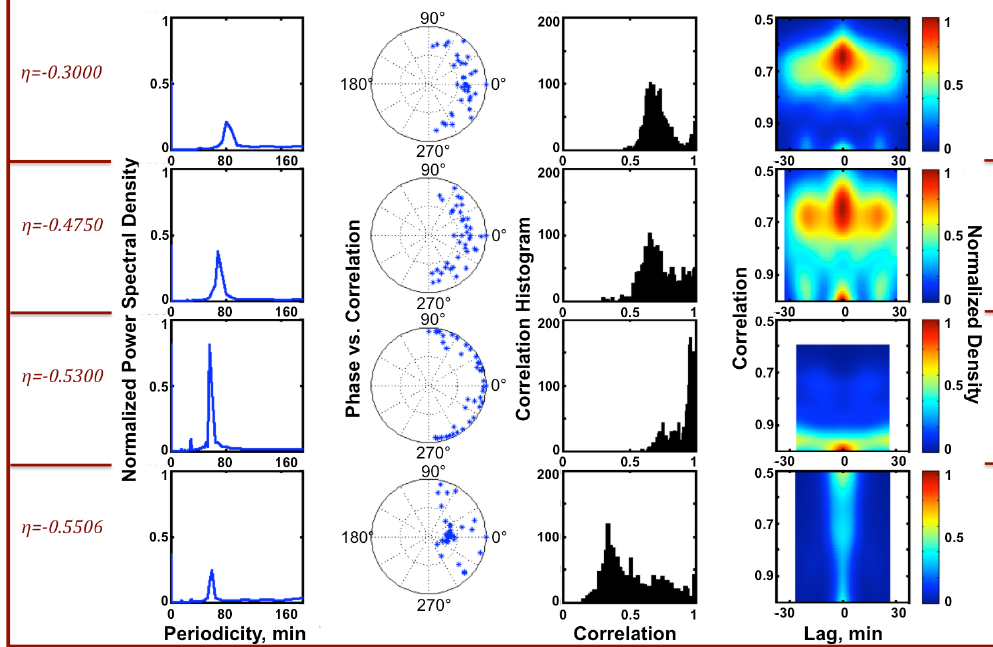
Fig. 9. Summary of the influence of η on an array of 41 clouds for η = − 0 . 3000, − 0.4750, − 0.5300, and − 0.5506 (top to bottom in any column). Column 1: average power spectral density in the time domain; Column 2: phase and correlation of the 41 clouds relative to the frequency and phase of cloud 1; Column 3: histogram of the correlations comprising the cross-correlation matrix (e.g. Fig. 8b); Column 4: two-dimensional probability distribution function of the correlation and lag based on the cross-correlation and cross-lag matrices. The progression to larger | η | is initially associated with an increase in system coherence and correlation (first 3 rows) but at sufficiently large | η | ( = − 0 . 5506), there is a shift to an unstable system with poorer coherence and correlation. In this state, a few clouds have very large H i and the system cannot support further increases in | η | without